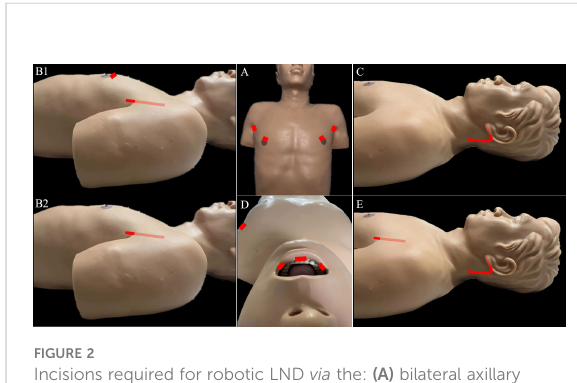
FIGURE 2 Incisions required for robotic LND via the: (A) bilateral axillary breast approach, (B) transaxillary approach, (C) retroauricular approach, (D) transoral approach, and (E) transaxillary and retroauricular